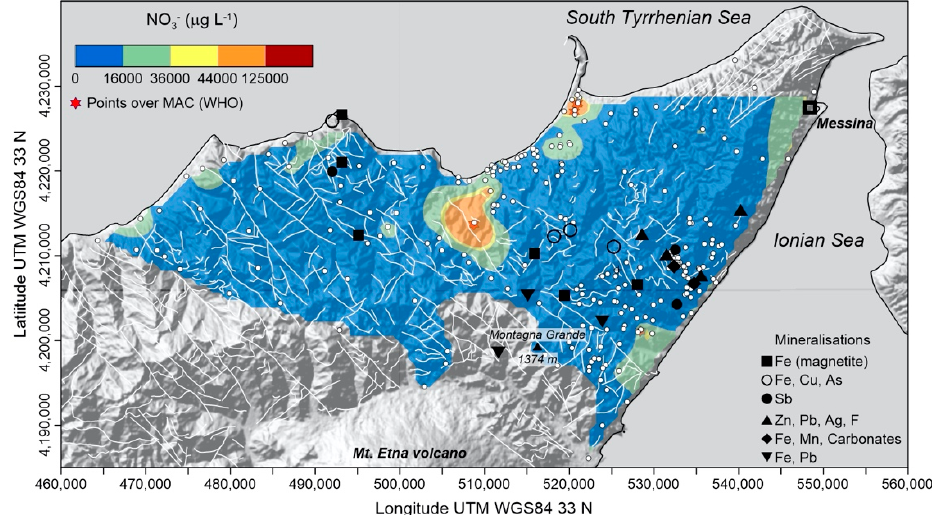
Figure 6. Concentration distribution map of NO 3 − , reporting locations of sampling points (with indication of those exceeding the related MACs) and main mineral deposits; tectonic lineaments (white lines) are also illustrated.